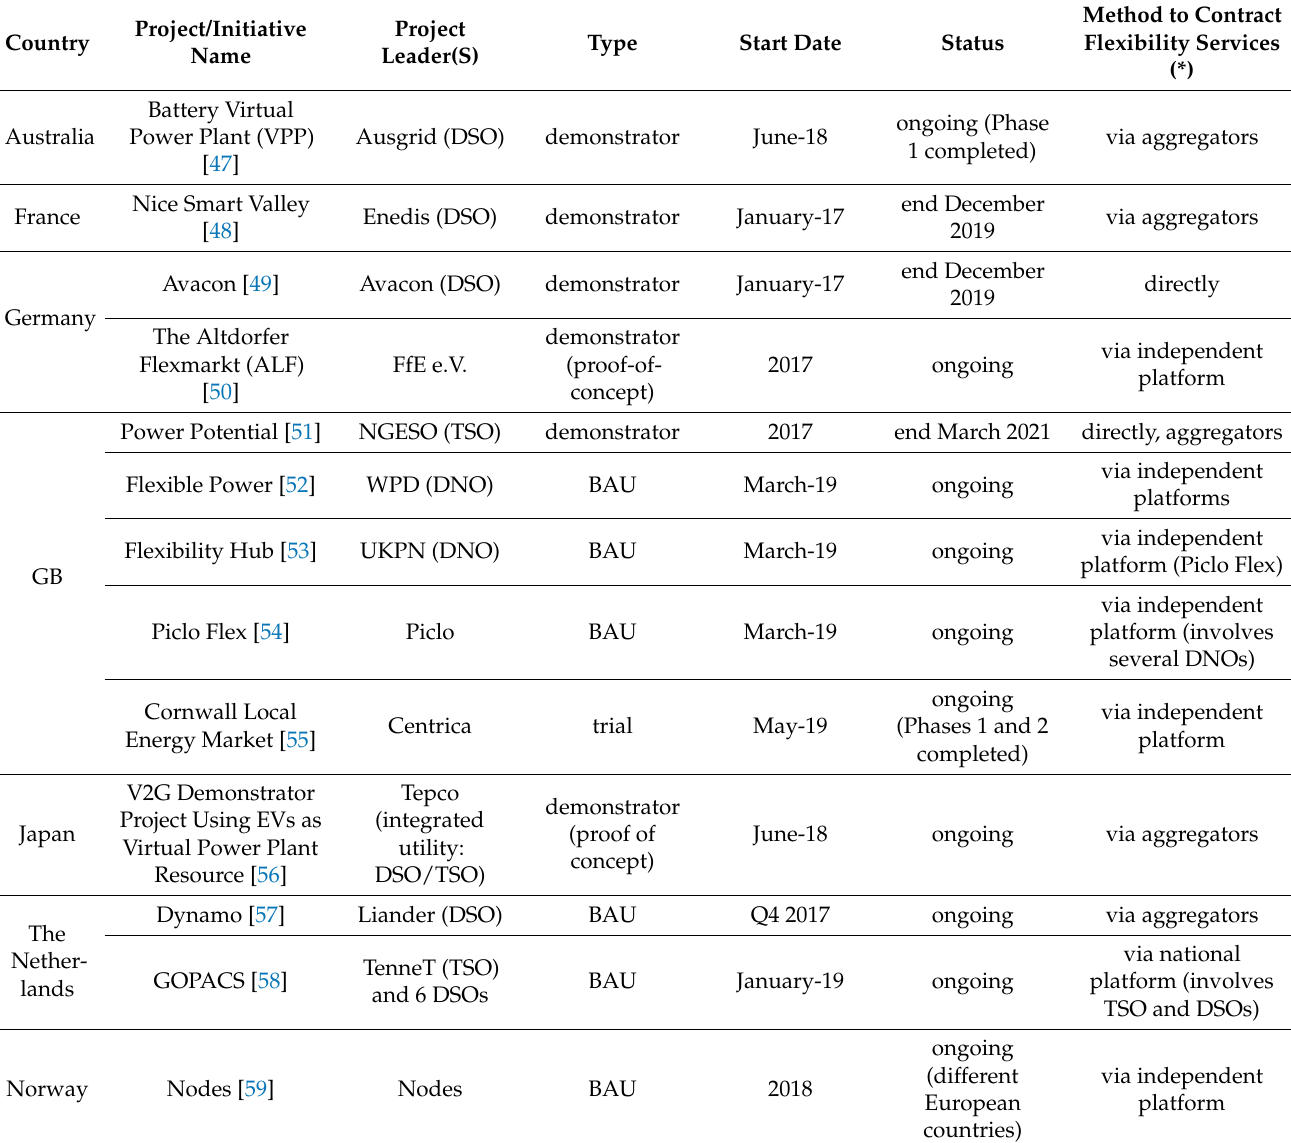
Table 1. Summary of